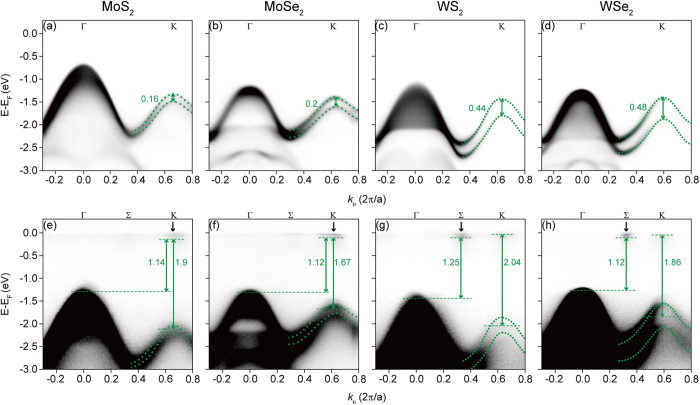
Electronic structure before and after K evaporation.(a–d) ARPES data along the Γ to K from pristine MoS2, MoSe2, WS2, and WSe2. Green dotted lines indicate the band dispersions near the K point. (e–h) ARPES data after potassium evaporation. The concentration of the doped electrons by potassium evaporation can be estimated from the Fermi surface volume. The estimated electron doping concentrations are 1.7 × 1013 cm−2, 2.5 × 1013 cm−2, 3.5 × 1013 cm−2, and 2.6 × 1013 cm−2 for MoS2, MoSe2, WS2, and WSe2, respectively.